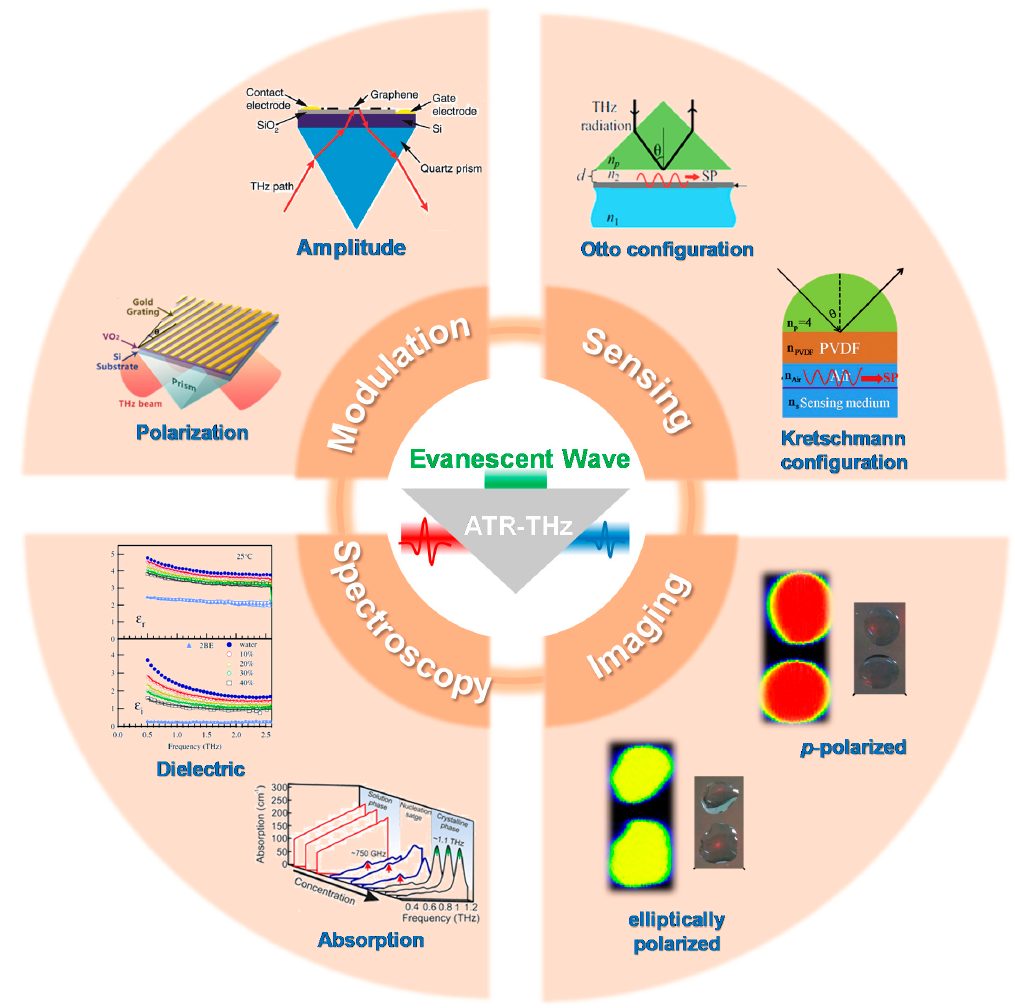
Figure 1. A summary of the THz attenuated total reflection (THz-ATR) application in modulation,